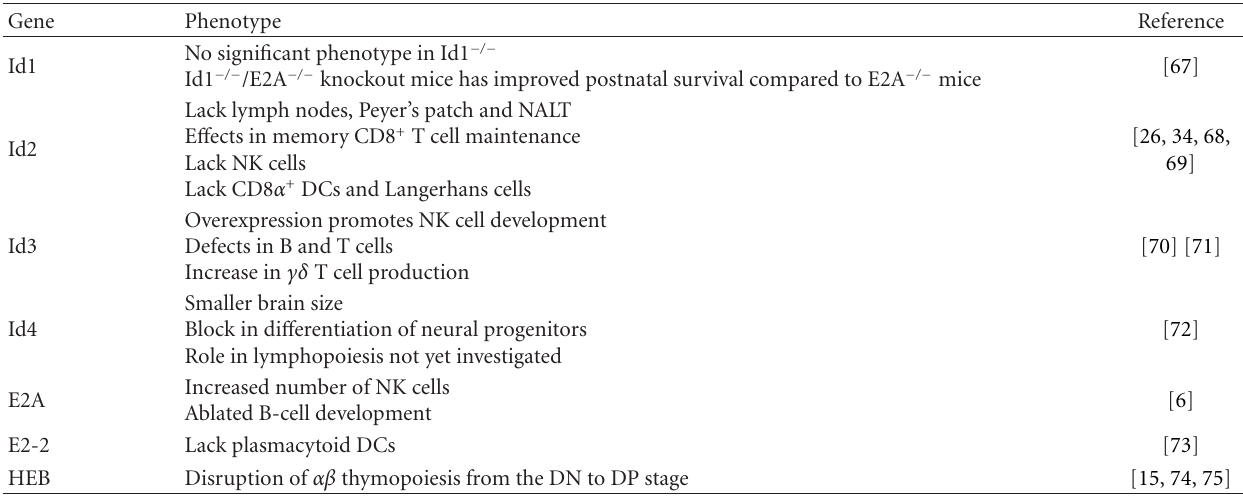
Table 1: Phenotype of mouse strains lacking Id and E